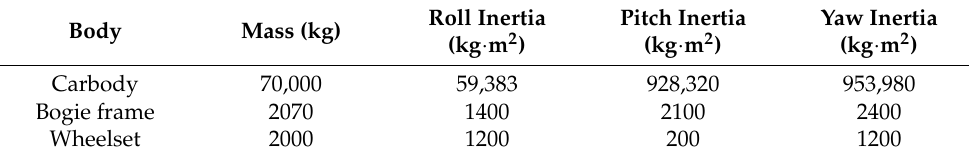
Table 2. Inertia parameters of the vehicle model. Reprinted from [17].